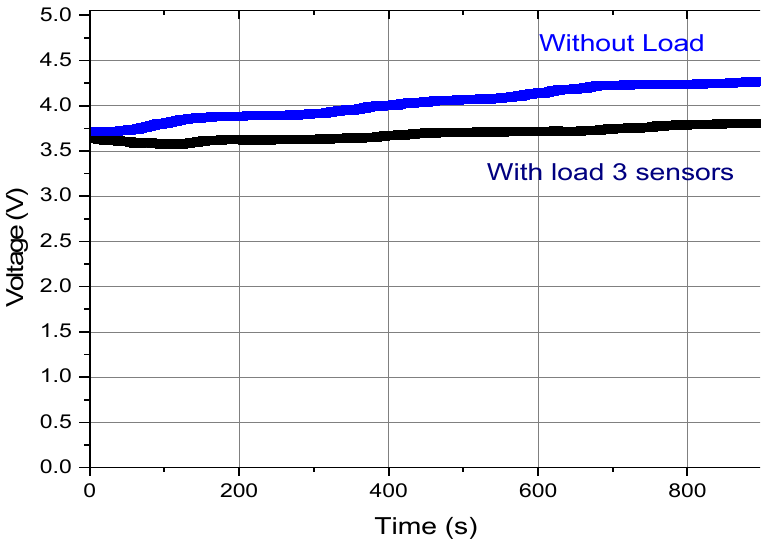
Figure 16. Capacitor voltage charging with 0.2 Hz movements, with 3 sensors load and without load.